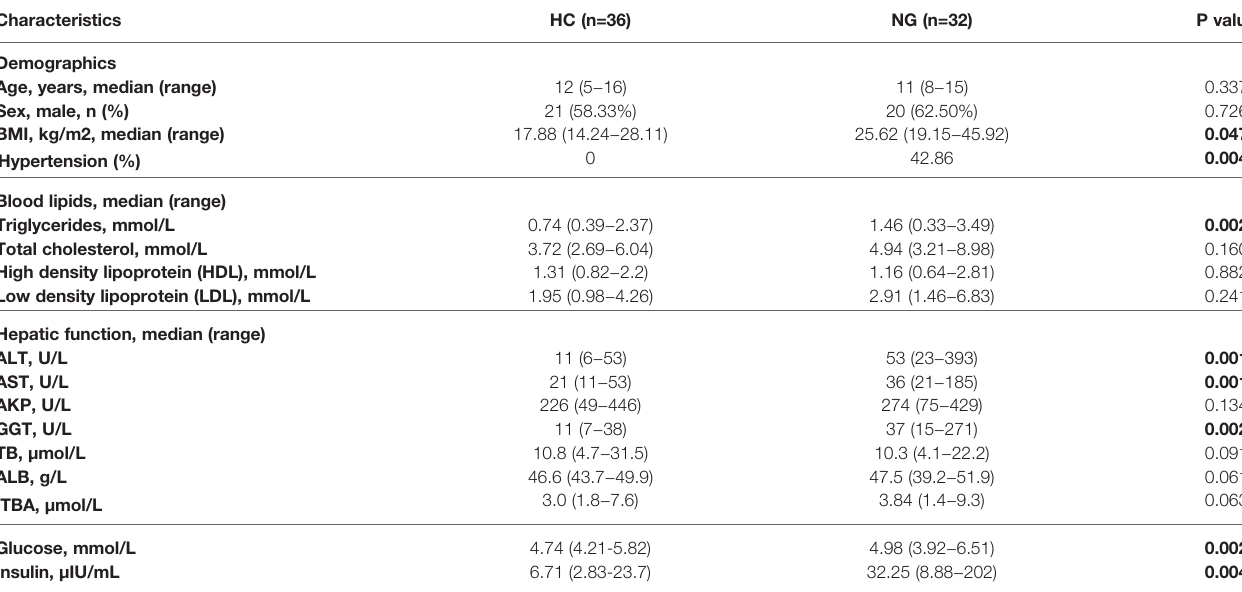
TABLE 1 | Subject characteristics.